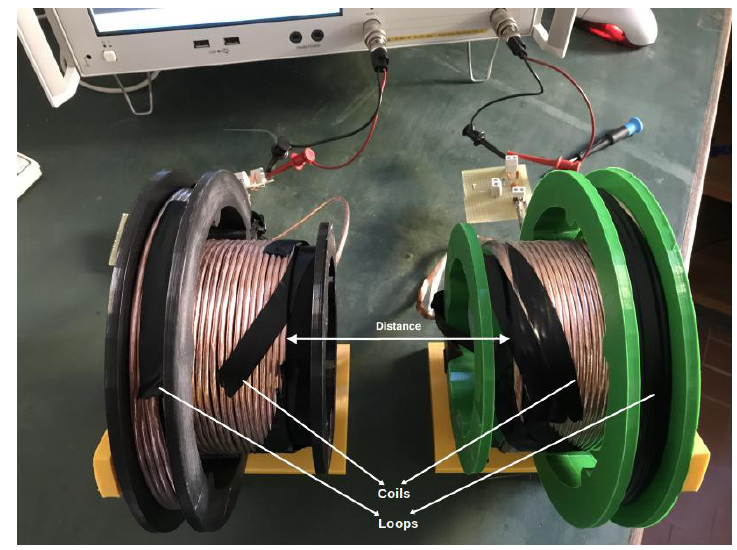
Figure 8. WPT system during measurement.